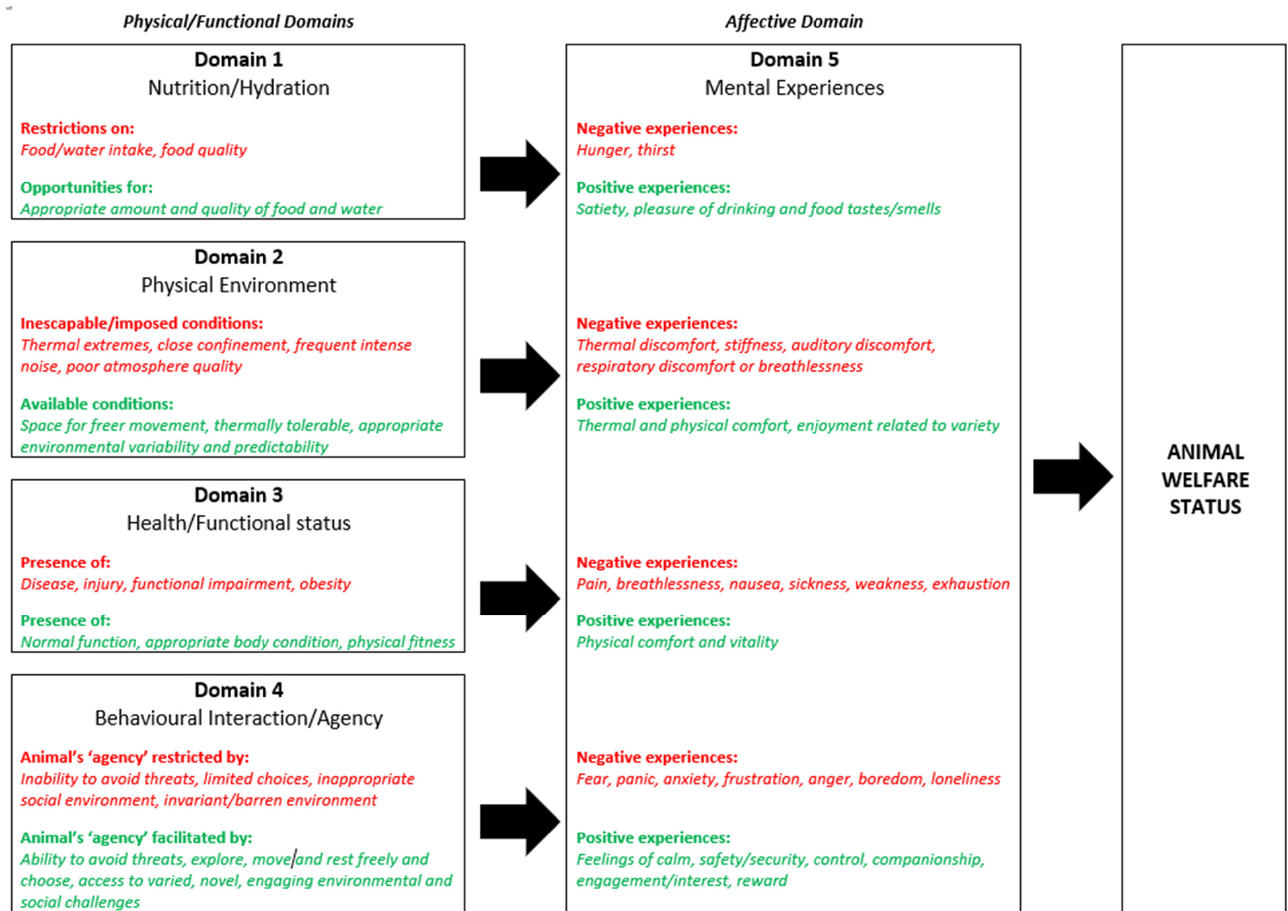
Figure 1. General structure of the 5 Domains model including some examples of how physical/functional impacts on the animal may relate to specific negative (and positive) mental experiences. Observable evidence of physical/functional states (welfare indicators) should be collated in Domains 1 to 4 and the associated mental experiences inferred in Domain 5. In Domain 4, ‘agency’ refers to the animal’s engagement in voluntary, goal-directed behavior. Note that the same/similar mental experi- ences can arise due to impacts in different physical/functional domains (e.g., breathlessness) could arise due to impaired respiration during suffocation (Domain 3) and due to poor atmosphere quality (Domain 2); exhaustion could arise due to starvation (Domain 1) or due to prolonged